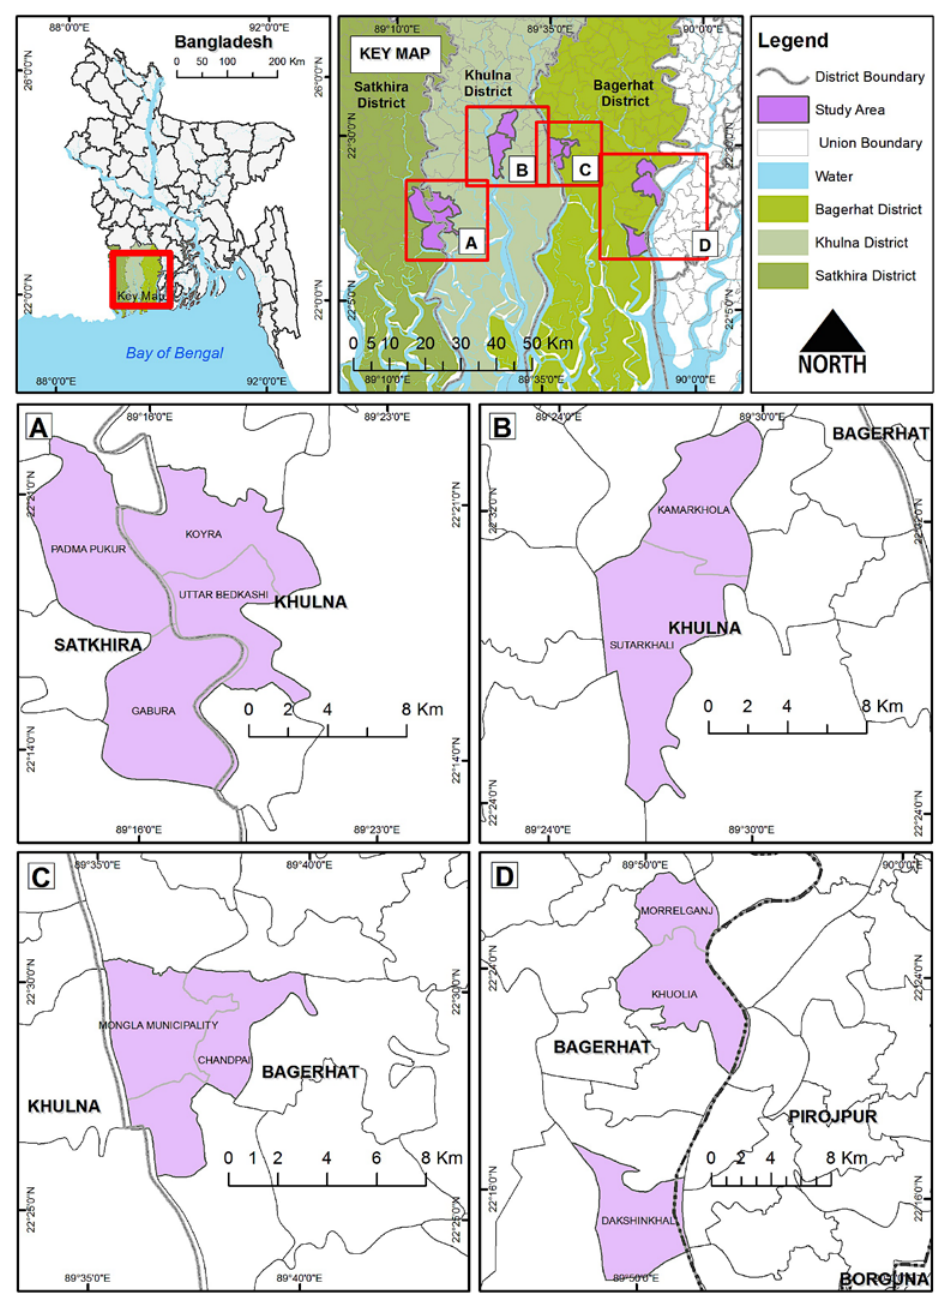
Figure 2. Study area, the southwest coastal region of Bangladesh. ( A ) Padmapukr, Gabura, Koyra and Uttar Bedkashi Union; ( B ) Kamarkhola and Sutarkhali Union; ( C ) Mongla Municipality and Chandpai Union; ( D ) Morelgonj Municipality, Khaulia and Sharankhola Union.